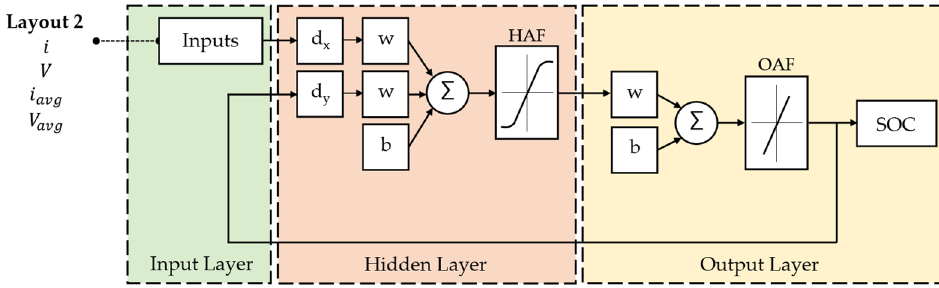
Figure 6. Considered recurrent ANN architecture with four inputs. Table 4. RNN—Layout 2: parameter values for training and final deployment. Table 4. RNN—Layout 2: parameter values for training and final deployment. Parameter